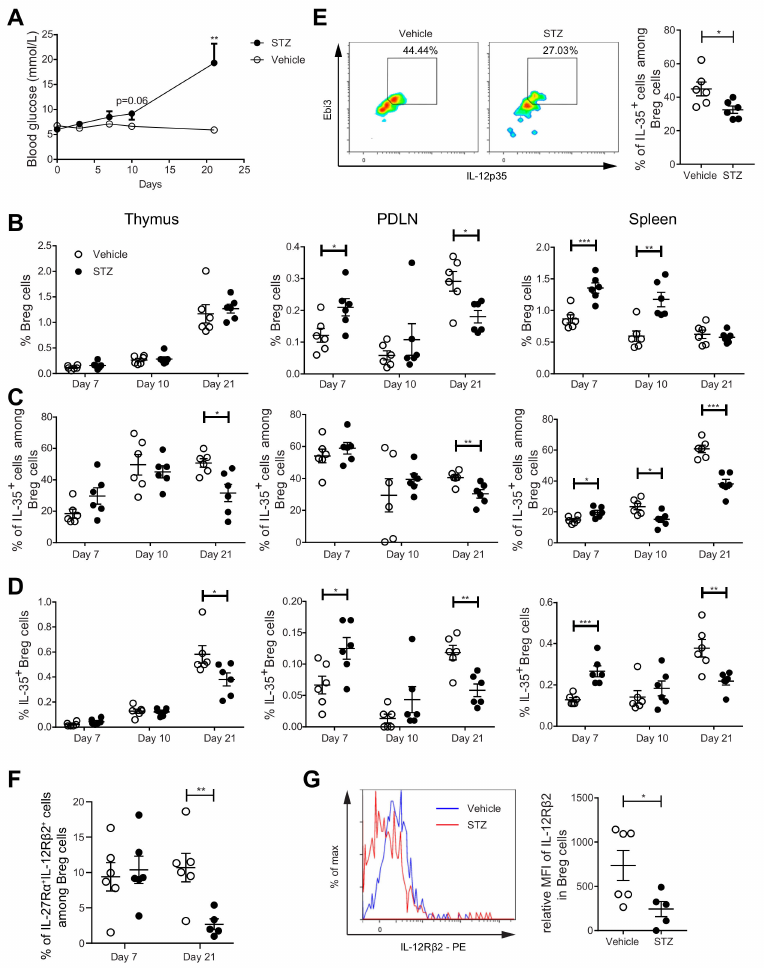
Figure 3. Kinetics of Breg cell proportions in MLDSTZ mouse model. Male CD-1 mice were injected intraperitoneally with saline or low doses STZ (40 mg/kg body weight) for 5 consecutive days. Blood glucose levels of the mice were measured on days 0, 3, 7, 10, and 21 after the first STZ injection ( A ). The mice were killed on days 7, 10, and 21. Single cells were prepared from removed thymic glands, PDLNs, and spleens. The proportions of ( B ) CD19 + CD1d + CD5 + Breg cells, ( C ) IL-35 + cells